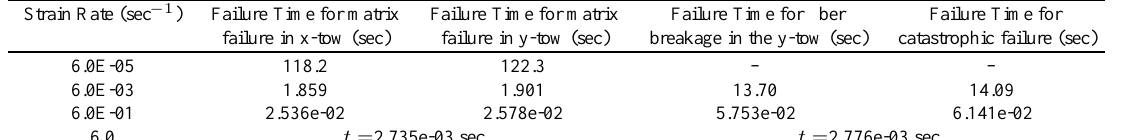
Table 3 Summary of failure sequence at various strain rates